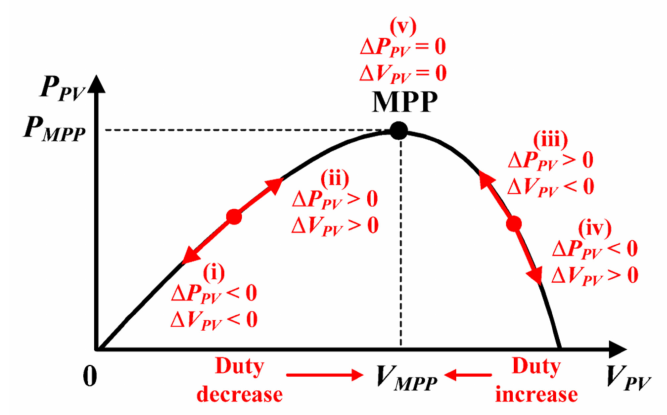
Figure 6. dp/dv sign at various points of the curve [11]. The flow chart of the P&O algorithm is shown in Figure 7.